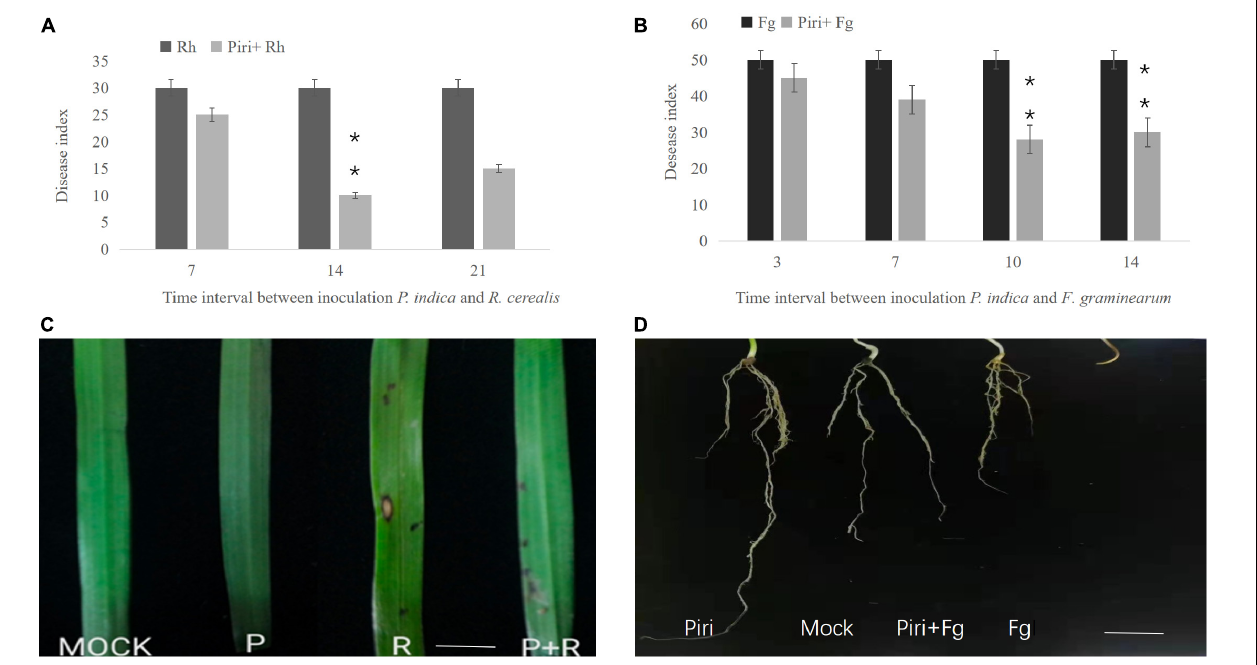
FIGURE 1 | Determination of the best time interval between inoculating wheat seedlings with Piriformospora indica and Rhizoctonia cerealis or Fusarium graminearum. (A) Time interval between inoculation P. indica and R. cerealis ; (B) Time interval between inoculation P. indica and F. graminearum . (C) Symptoms of sharp eyespot caused by R. cerealis on wheat leaves under different treatment ( P. indica inoculation was 14 days before R. cerealis infection ) ; (D) Symptoms of root rot caused by F. graminearum on wheat roots under different treatment ( P. indica inoculation was 10 days before F. graminearum infection ) . Piri, P. indica ; Fg, F. graminearum ; Rh, R. cerealis ; Piri + Fg, P. indica + F. graminearum ; Piri + Rh, P. indica + R. cerealis.